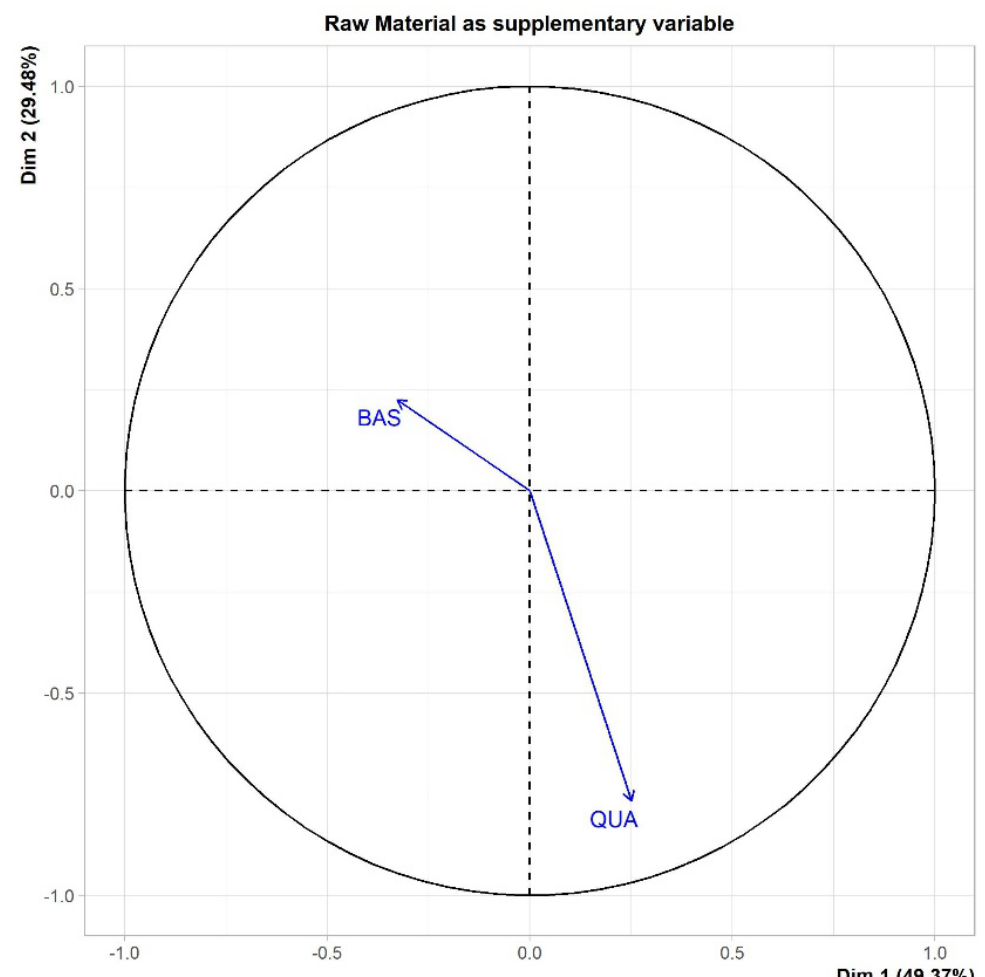
Figure 16. Graph showing the disposition of raw material as supplementary variable for core